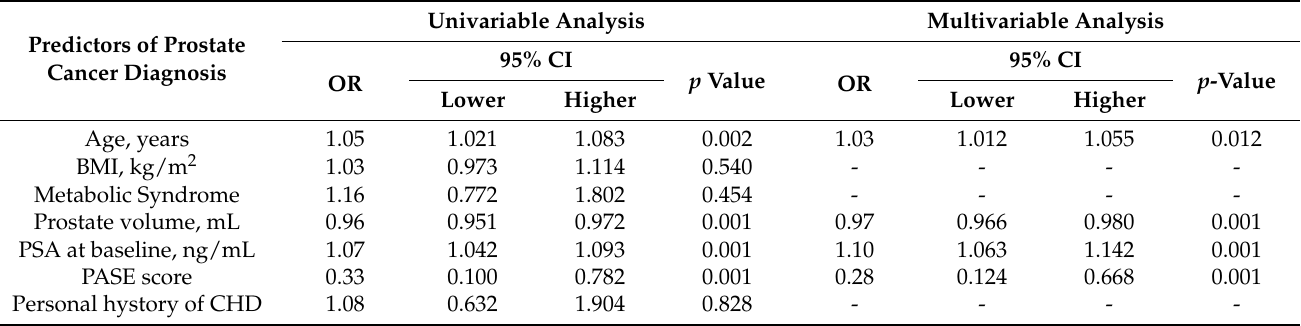
Table 2. Univariable and multivariable logistic regression analyses to identify predictors of prostate cancer diagnosis.